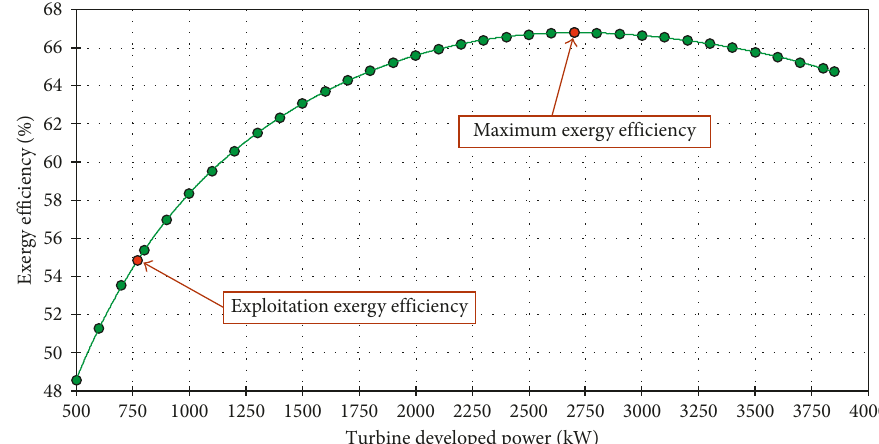
Figure 6: Steam turbine exergy efficiency change during the developed power variation—operating point 5.